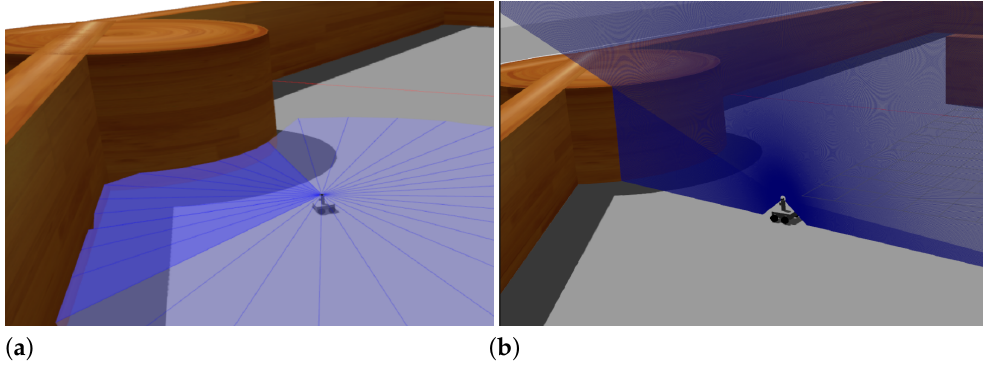
Figure 13. Examples of 2D laser scans acquired in the first ( a ) and in the second ( b ) stages in the